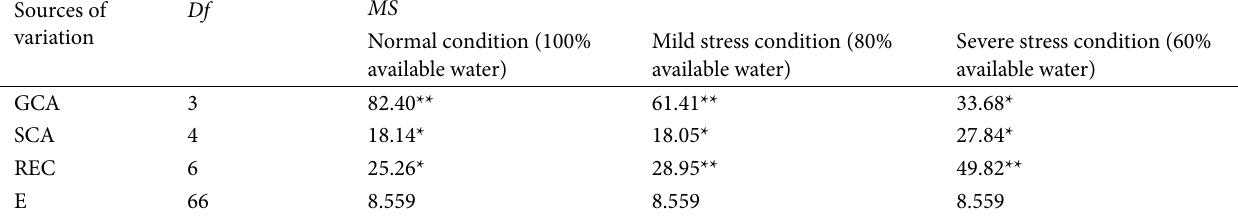
Table 3 Analysis variance of general and specific combining ability of potato tuber yield in genotypes under three environmental